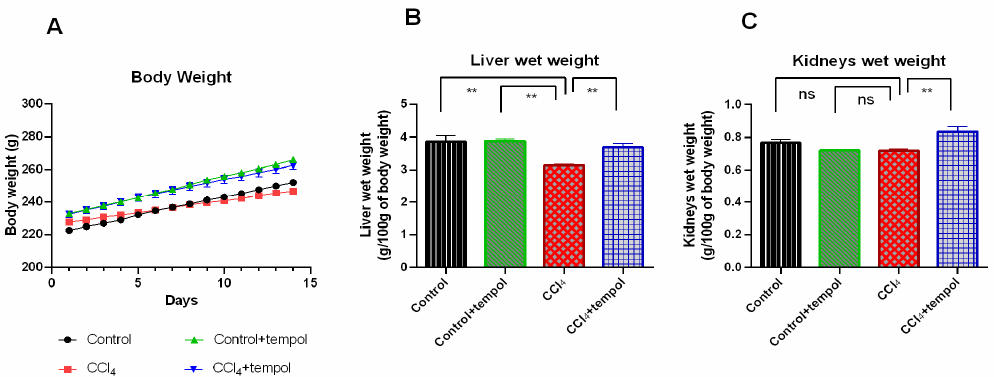
Figure 1. Effect of tempol on body weight, liver wet weight, and kidneys wet weight in CCl 4 induced rats. For body weight, 14 days of body weight are shown here, which was recorded every day. Every value was represented as mean ± SEM. Every value was represented as mean ± SEM. N = 6. One-way ANOVA followed by Tukey’s test were performed for statistical analysis. For statis- tical significance, p < 0.05 is considered significant in all cases. Here, ns means p > 0.05, ** means p < 0.001 .